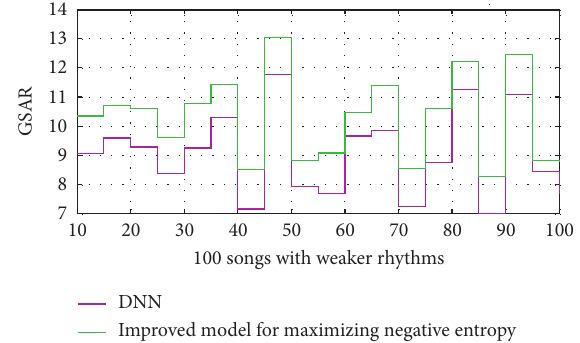
Figure 9: The separation results of 100 pieces of music with weaker rhythms in MIR-1K.